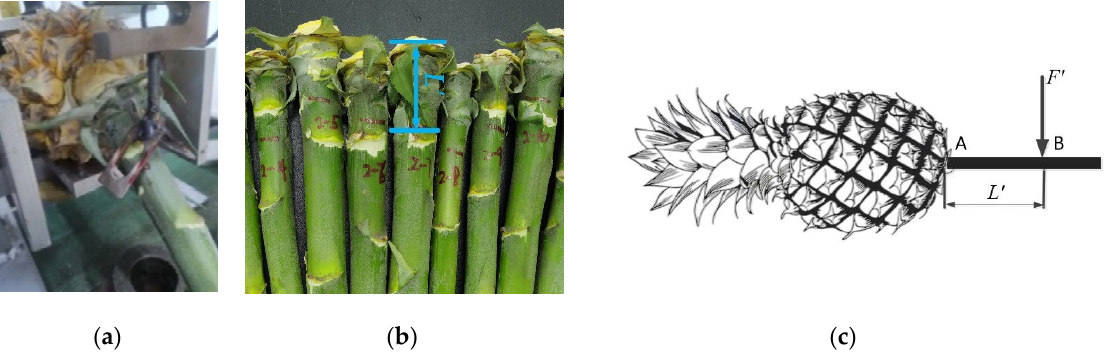
Figure 4. AZ-C layer of pineapple bending moment experiment. ( a ) Experimental process. ( b ) Mo- ment Arm. ( c ) Simplified force diagram of the abscission layer bending test at the calyx of pineapple.